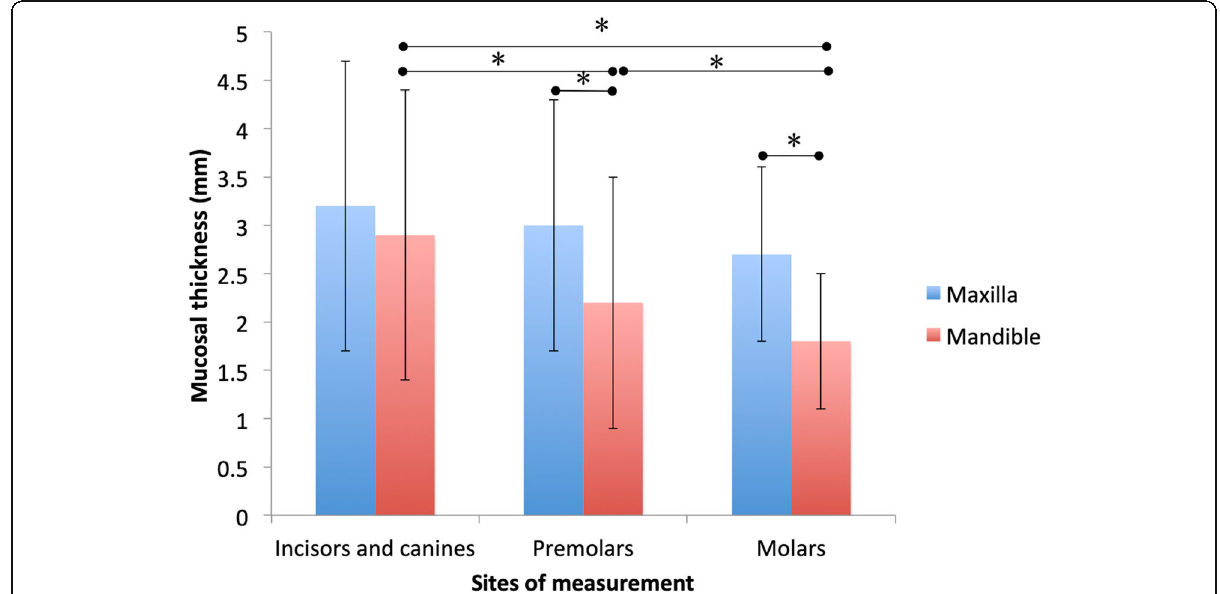
Fig. 5 Comparison of mucosal thickness between the maxilla and mandible at each site. * p<